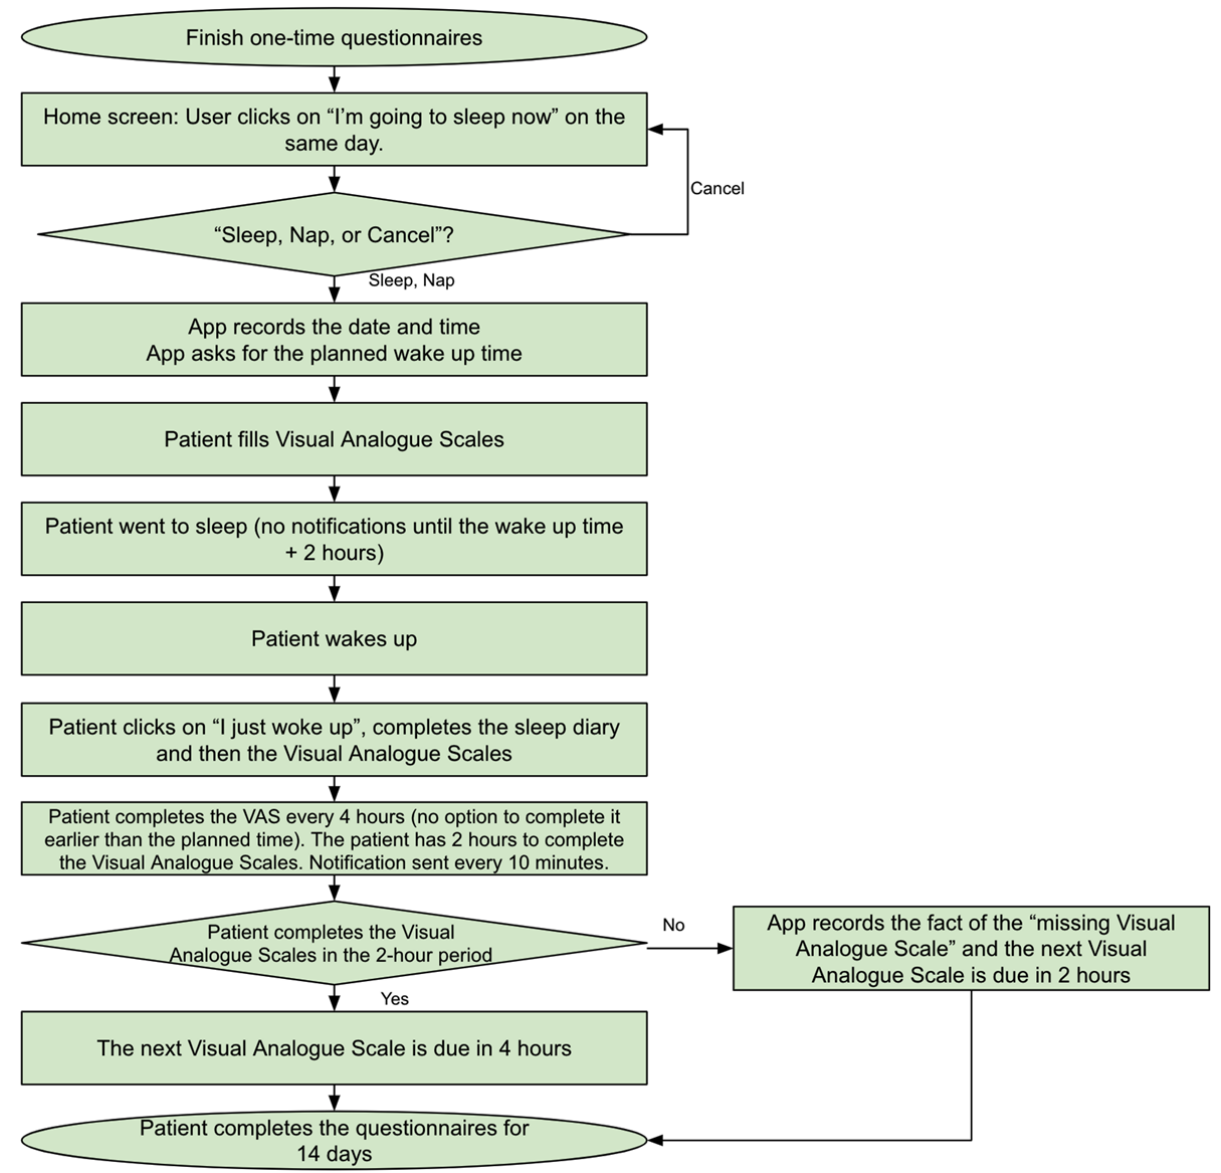
Figure 4. Algorithm of Visual Analogue Scale and sleep diary assessments. VAS: Visual Analogue